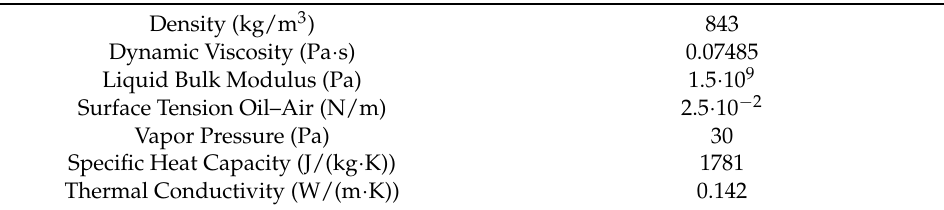
Table 3. Fluid properties of the automatic transmission oil at 20 ◦ C and 1 bar.